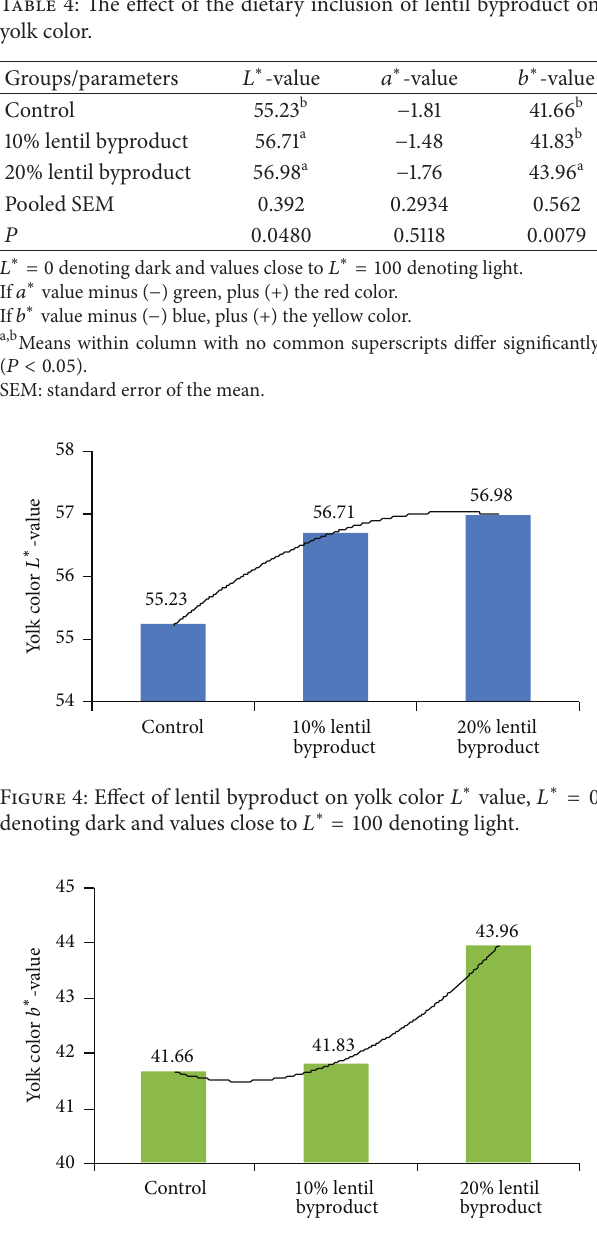
Figure 5: Effect of lentil byproduct on yolk 𝑏 ∗ value; if 𝑏 ∗ value minus ( − ) blue, plus (+) the yellow